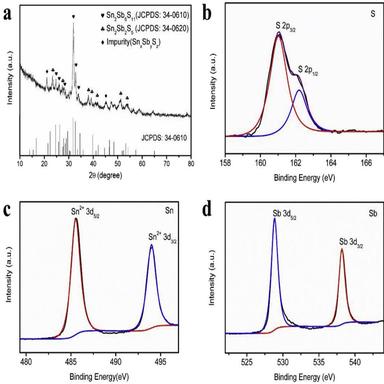
a) XRD pattern of yolk-shell Sn-Sb-S microflower composite. XPS high-resolution spectra of the b) S 2p, c) Sn 3d, and d) Sb 3d for the yolk-shell Sn-Sb-S microflower composite.